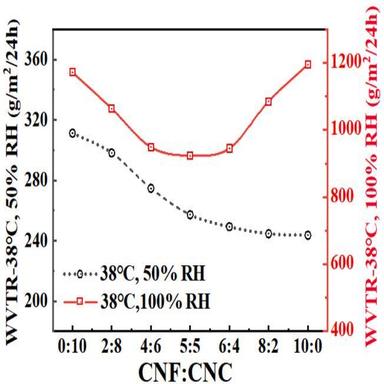
WVTR of nanocomposite films with different ratios of CNF/CNC.